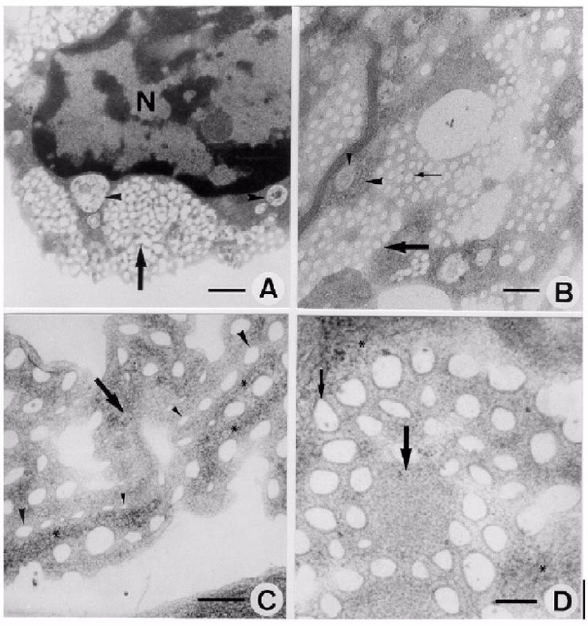
Figure 9 TEM micrographs of sectioned control- (A-B), and di- h-HALI treated LSECs (C-D).(A) Sectioning through the nuclear region (N) reveals a complex sponge-like appearance of fenestrae lying around the nucleus (arrow). Notice the presence of vacuoles (arrowheads). Scale bar, 1 µ m. ( B ) Sec- tion through the peripheral cytoplasm reveals fenestrae grouped in sieve plates (large arrow). Note the difference between fenestrae (small arrow), endocytotic vesicles (large arrowhead), and vacuoles (small arrowhead). Scale bar, 1 µ m. ( C ) High magnification image of a FFC (large arrow) after 60 minutes of di-h-HALI treatment, showing small fenestrae (small arrowheads), which form rows of fenestrae with increasing size (large arrowheads). Notice filamentous struc- tures (asterisks). Scale bar, 200 nm. ( D ) FFC (large arrow) after 120 minutes of di-h-HALI treatment. Notice the granu- lar pattern of the FFC and the absence of connected fenestrae rows at this stage. Fenestrae (small arrow); fila- ments (asterisks). Scale bar, 200